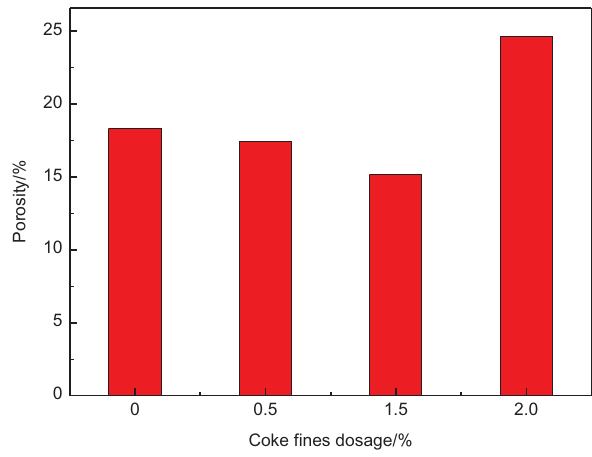
Figure 7: Effect of coke fines dosage on porosity of fired pellets (Preheating at 1,050°C for 15 min and firing at 1,250°C for 15 min).